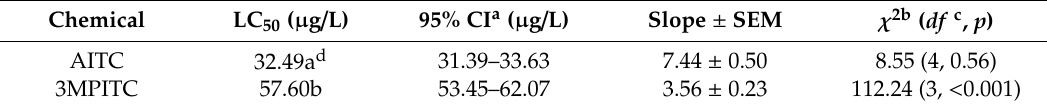
Table 2. Fumigation toxicity of two isothiocyanates against S. invicta workers.